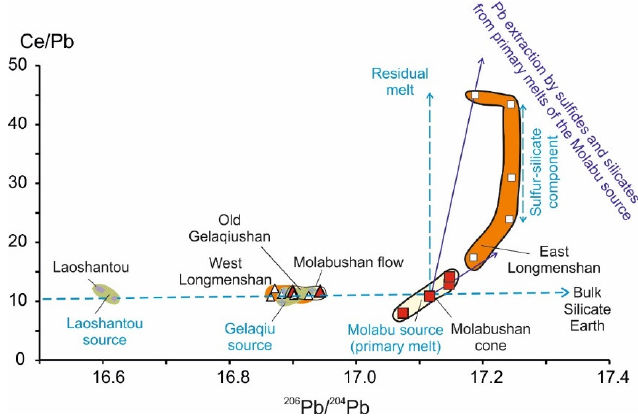
Figure 15. Ce/Pb versus 206 Pb/ 204 Pb diagram. Symbols are as in Figures 5 and 12. Figure 15. Ce / Pb versus 206 Pb / 204 Pb diagram. Symbols are as in Figures 5 and 12.